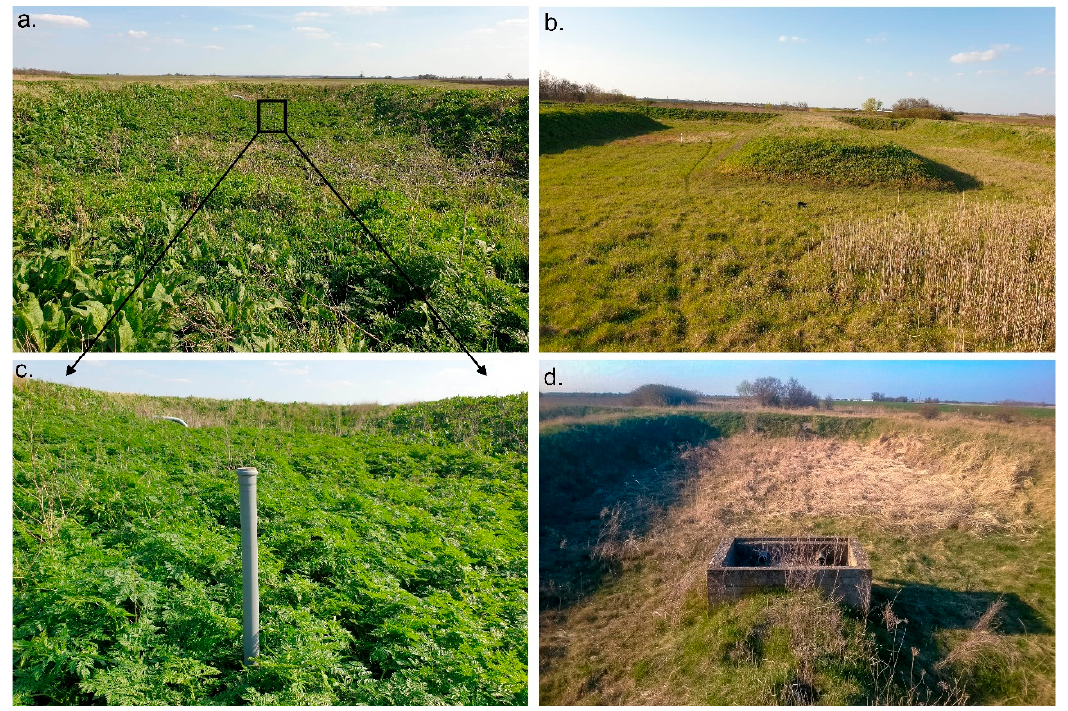
Figure 2. The present state of the liquid waste disposal. ( a ) Infiltration basin; ( b ) oxidation basin; ( c ) nitrophilic vegetation in the infiltration basin. ( d ) last oxidation basin. Between 1990 and 2020, the population of the municipality ranged between 2907 and 2611 inhabitants, with a continuous decreasing tendency [42]. The annual water extraction of the municipality has been between 90,000 and 120,000 m 3 over the last decade, of which